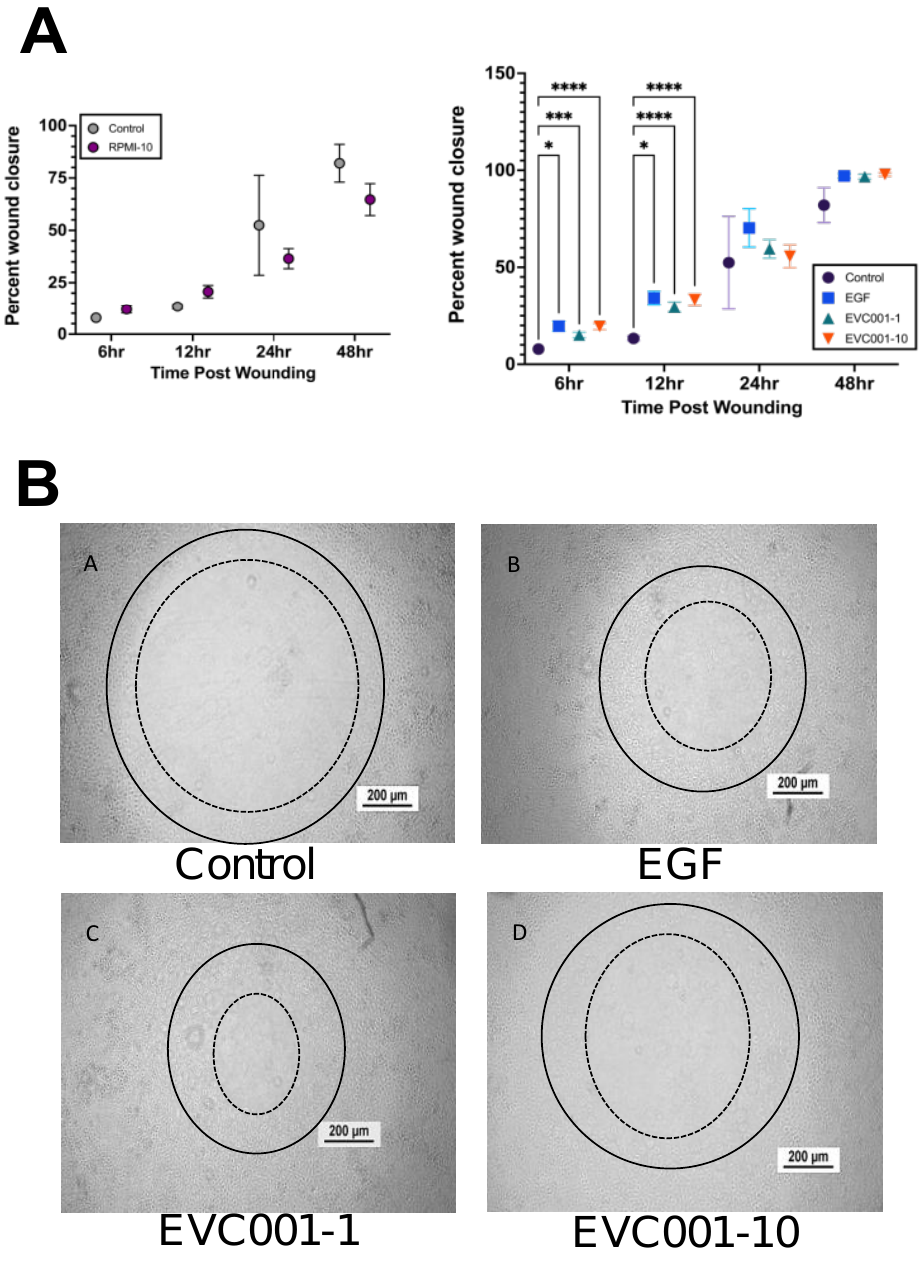
Figure 5. Wound healing assay results show B. infantis EVC001 metabolites can improve intestinal epithelial cell wound healing. ( A ) Compared wound healing results between sham and RPMI and results from the wound healing assay ( n ≥ 3 wounds per group) ( B ) Representative microscopy images of the epithelial cells with the original wound size at the 0-h time point (solid line) added for comparison to the degree of healing at the 12-h time point (dashed line). For all p values, * ≤ 0.05, *** ≤ 0.001, and **** ≤ 0.0001.